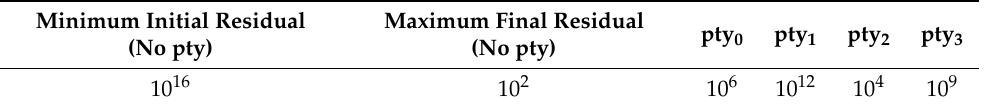
Table 5. Penalty factors for the simulation.